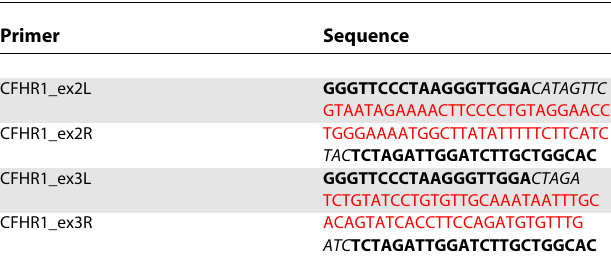
Table 3. Primer Sequences for PCR Amplification and Table 4. MLPA